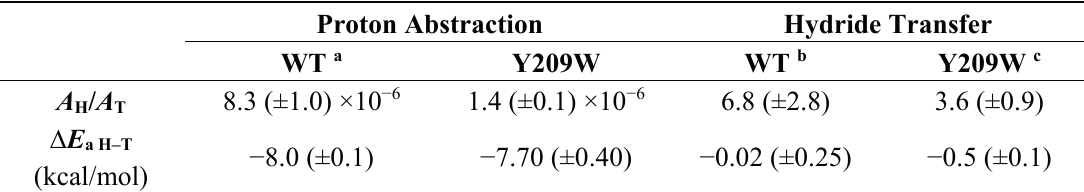
Table 1. Isotope effects on Arrhenius parameters of wild type (WT) and Y209W Escherichia coli thymidylate synthase ( ec TSase) on the proton abstraction and the hydride